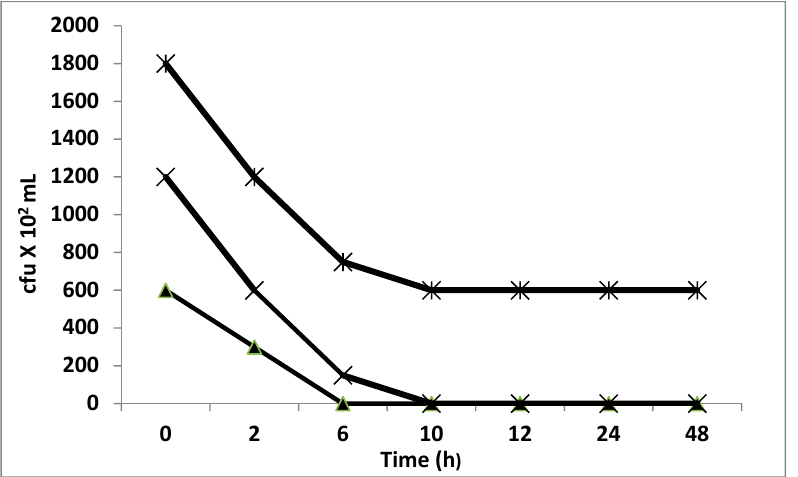
Figure 3. The viability of Staphylococcus aureus in the presence of varying concentrations of gallic acid extracted from Ajwa date pits (0, 100, and 200 µg/mL). The average of three replicates (mean ± standard deviation) is used. Student’s t-test was used to assess statistically significant differences between samples, and p ≤ 0.05 was considered significant.